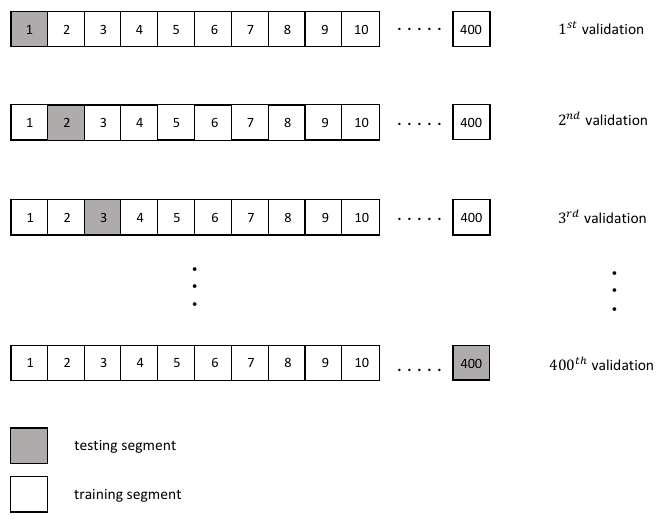
Figure 10. LOO cross-validation scheme for the database described in this